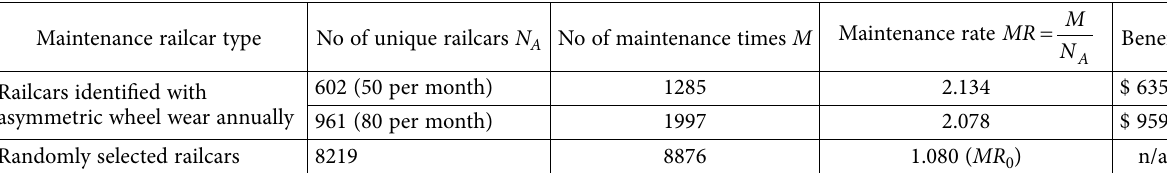
Maintenance railcar